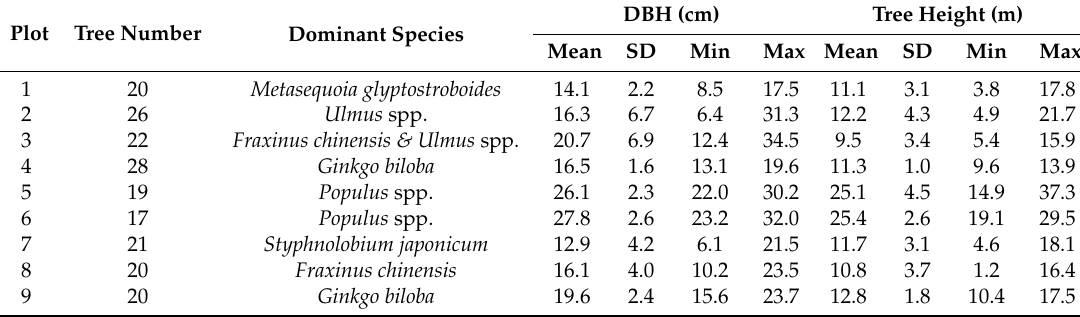
Figure 4. The workflow of our system.